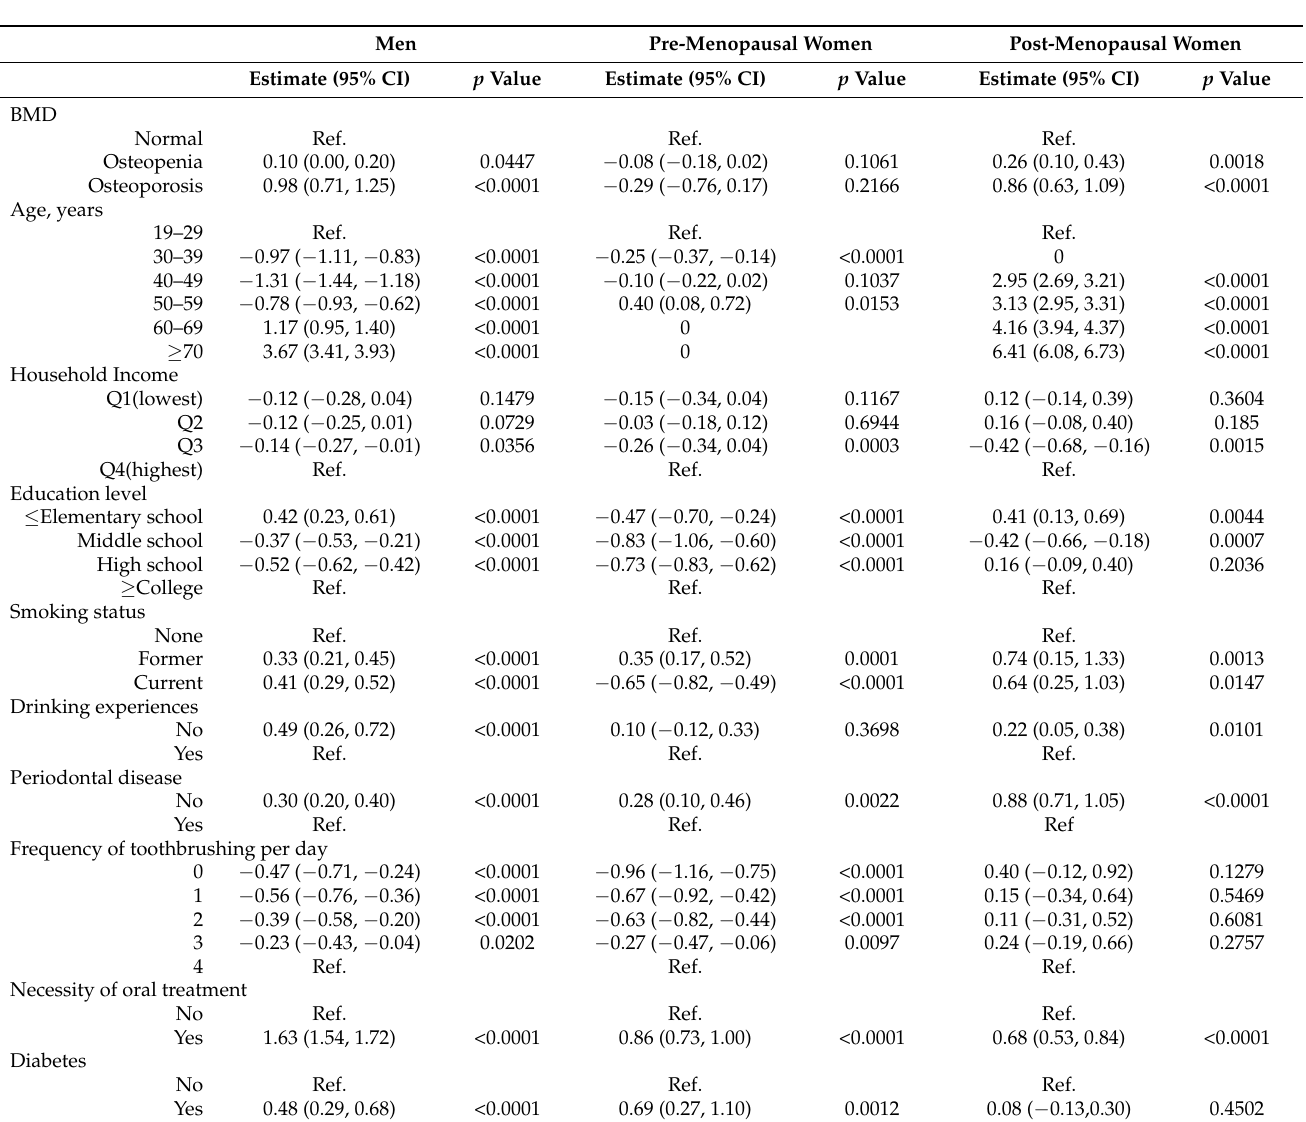
Table 3. The results of multiple survey regression analysis with comparison of DMFT index on bone mineral density by sex and menopausal status.